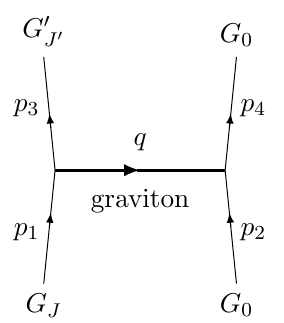
Figure 10 . The phase-shift δ GG ′ for glueball mixing in the limit N